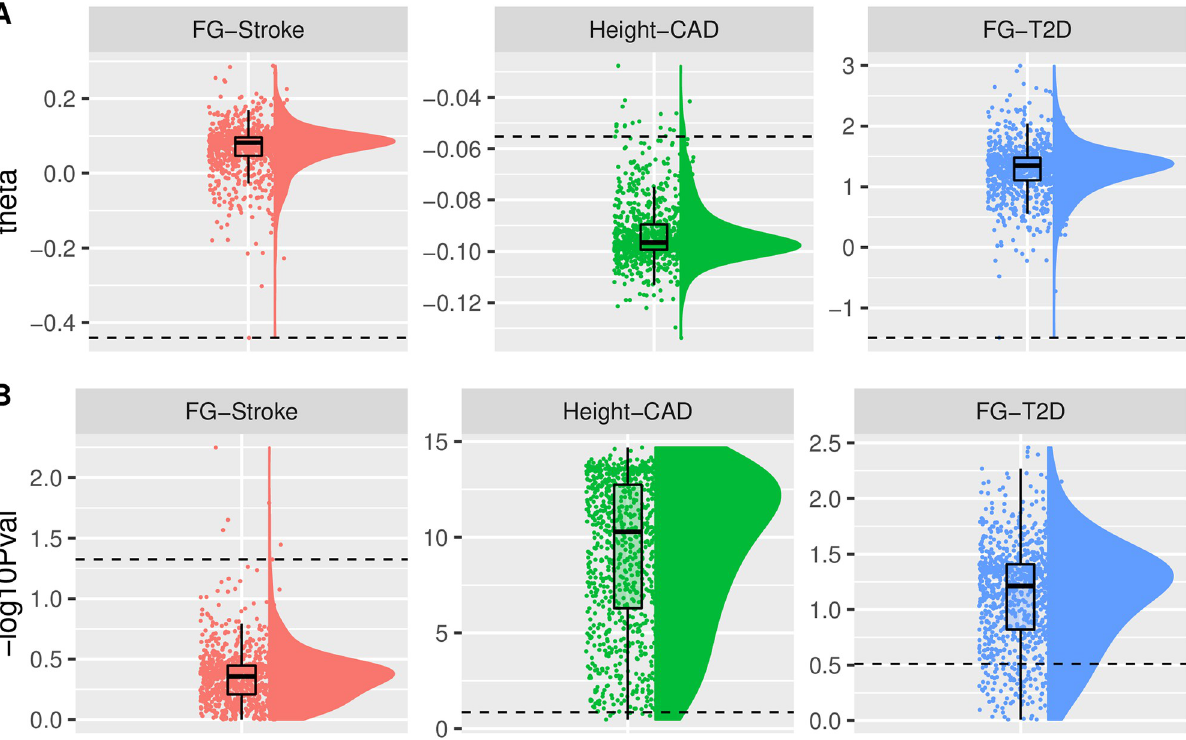
Fig 2. Three real data examples showing different results from different coding schemes in Egger regression. Panel A: estimates of the causal effect; Panel B: -log 10 (p-value)’s of the causal effect. The dashed line in each plot corresponds to the result from the default coding.